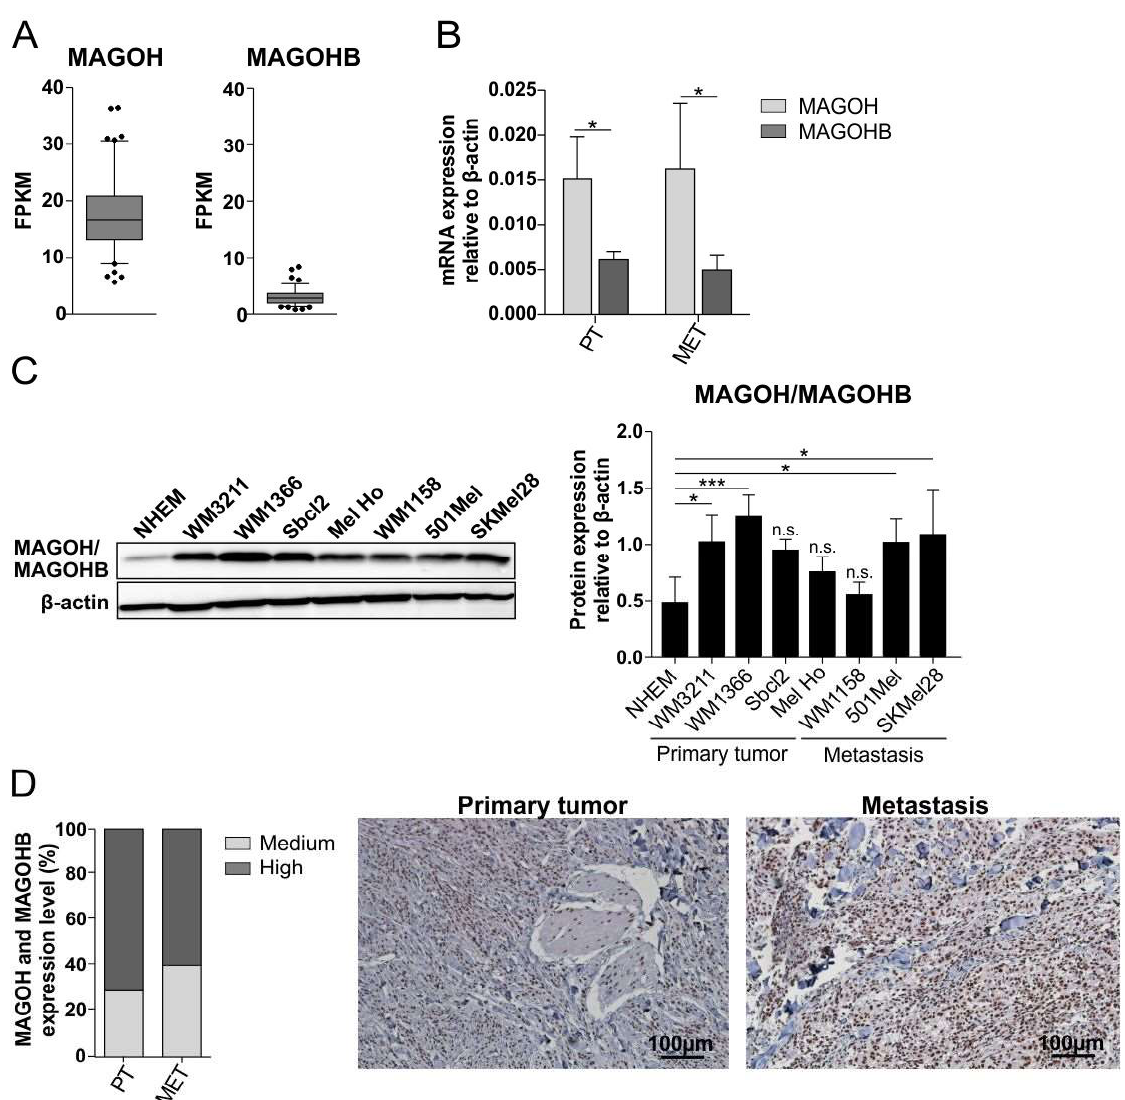
Figure 1. MAGOH mRNA is predominantly expressed compared to MAGOHB in cutaneous melanoma patients and tumor derived cutaneous melanoma cell lines and MAGOH/MAGOHB protein levels are enhanced in melanoma cells and skin melanoma derived tissue